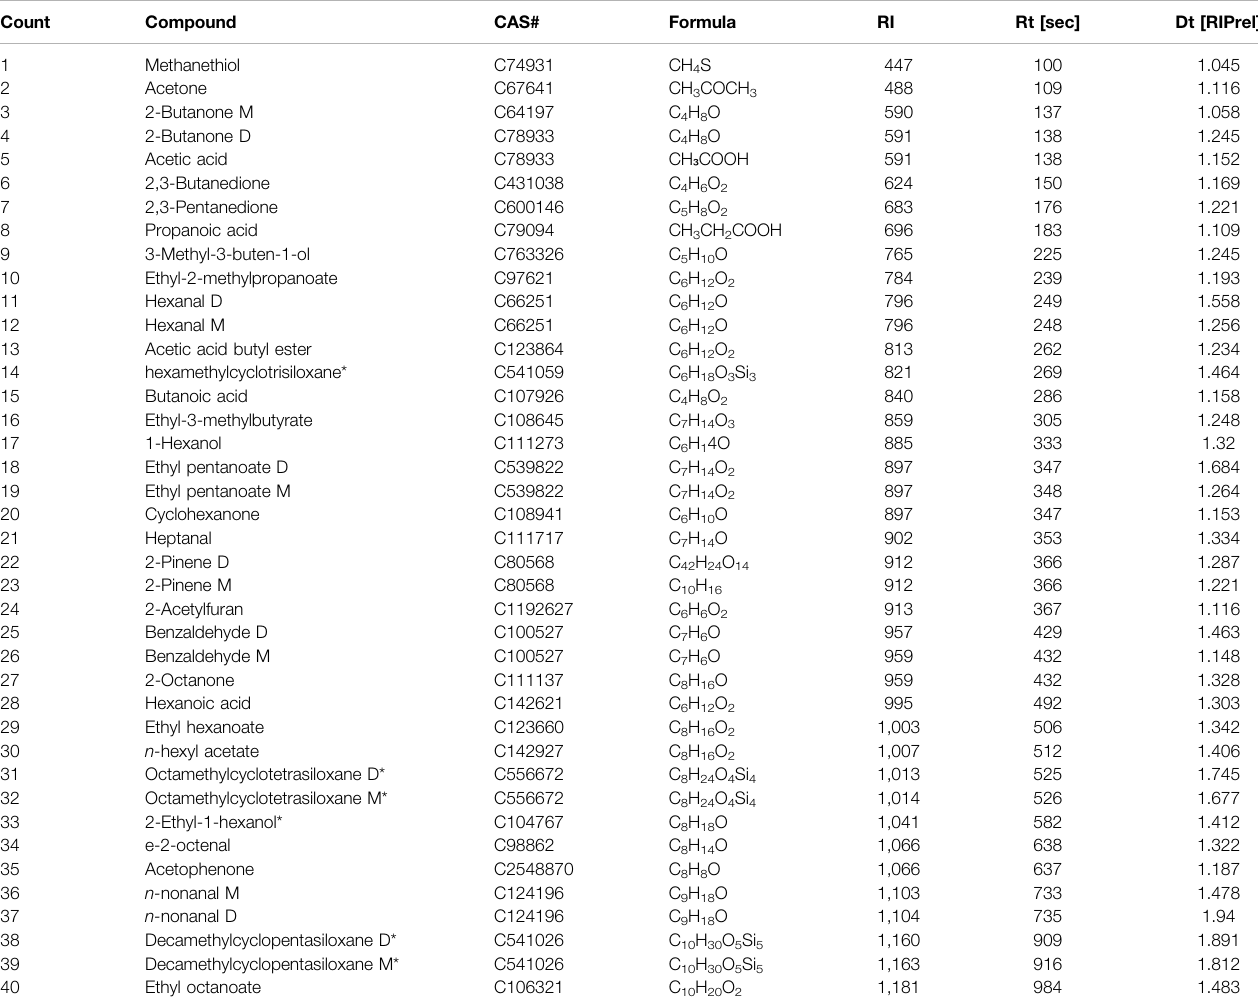
TABLE 2 | Details of the 34 volatile organic compounds detected in the sediment